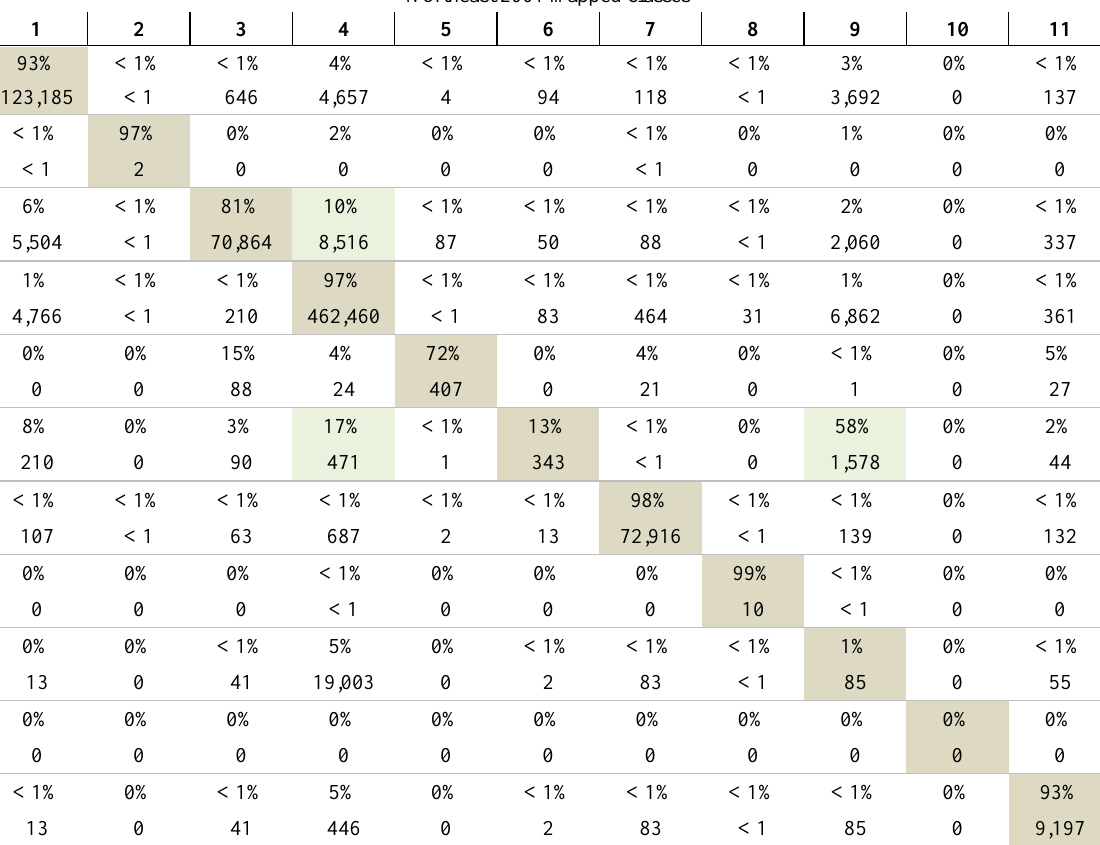
Table 2b. Percent and area (km 2 ) for each general land cover class in the 2001 and 2011 maps for the Northeast geoarea. Codes correspond to the land cover classes in Table 1. Diagonals are highlighted for ease of reading, and off diagonals are highlighted where greater than 10% of the 2001 General Land Cover Class was different in